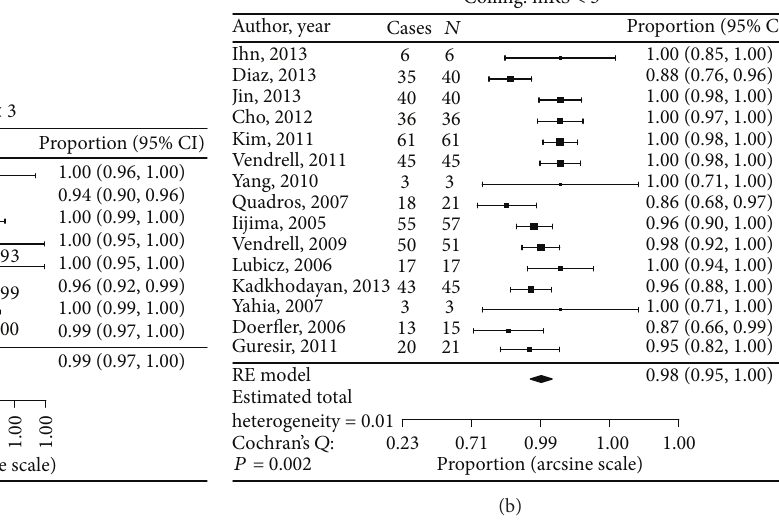
Figure 4: Data analysis of clinical outcome in both clipped and coiled